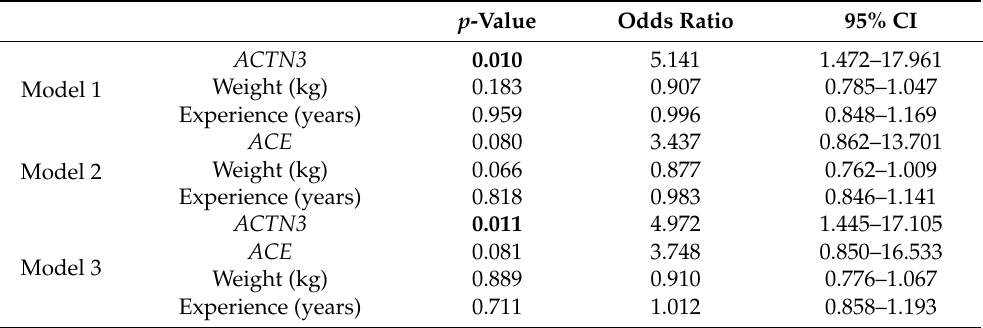
Table 5. Models of association between the ACTN3 R577X genotypes (Model 1) and ACE I/D (Model 2), and the combination of ACTN3 R577X and ACE I/D (Model 3) with injury severity. Bold emphasizes values of p <